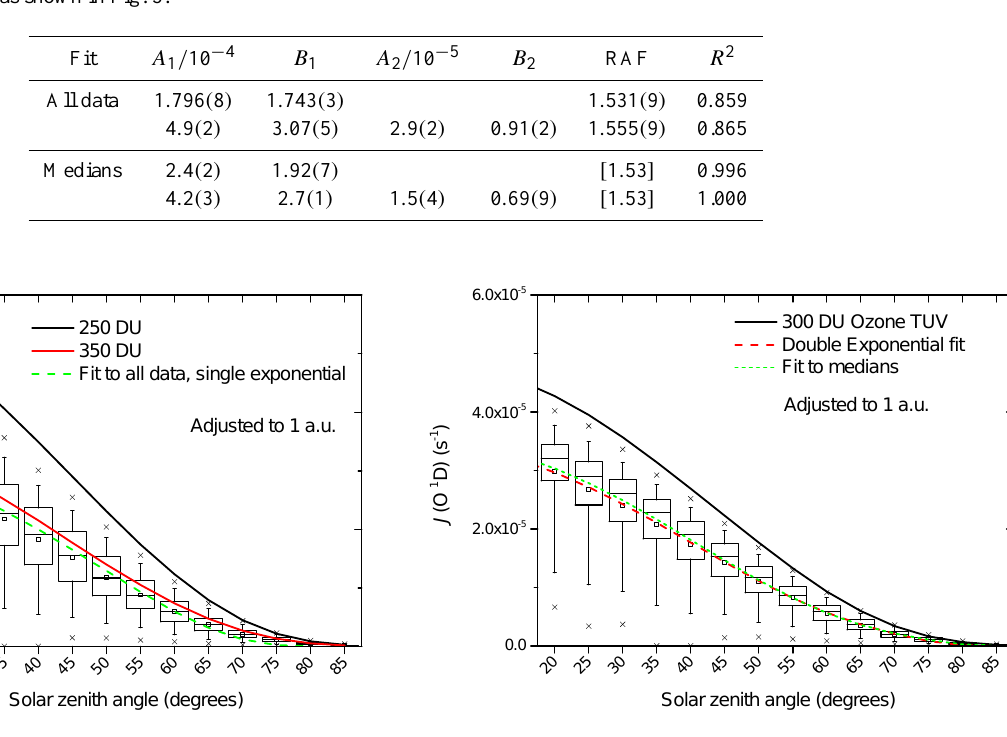
Figure 5. Cape Grim measurements of J (O 1 D) adjusted to a nom- inal 300DU and 1a.u. The solid line is the calculated J (O 1 D) for clear skies and 300DU ozone column and an aerosol optical depth of 0.05 using TUV 5.0 (Madronich and Flocke, 1997). The two bro- ken lines are the results of the fits using two exponential terms to either all data or the median value of each bin (see also Table